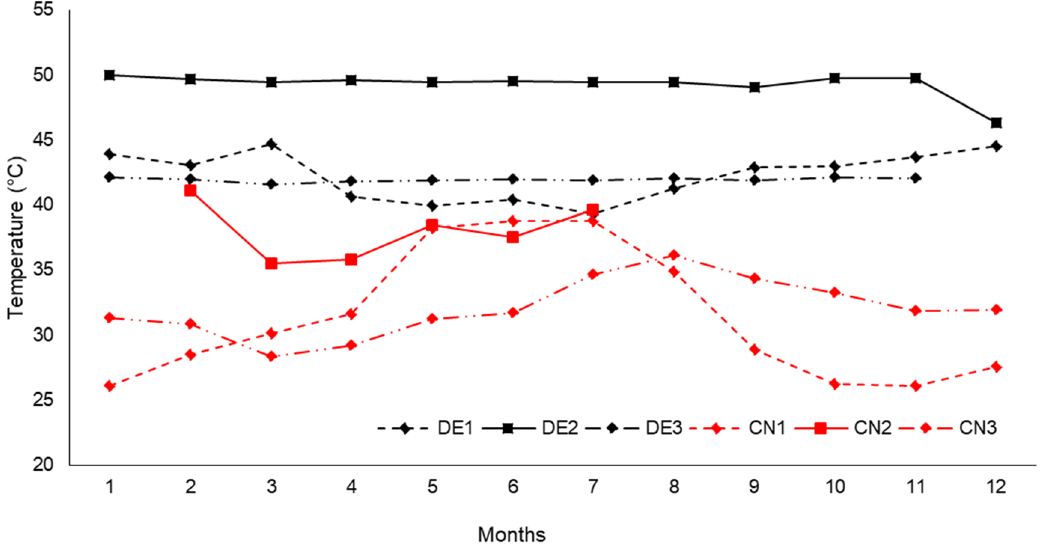
Figure 2. Year-round digester temperature of the selected German (DE) and Chinese (CN) biogas plants.